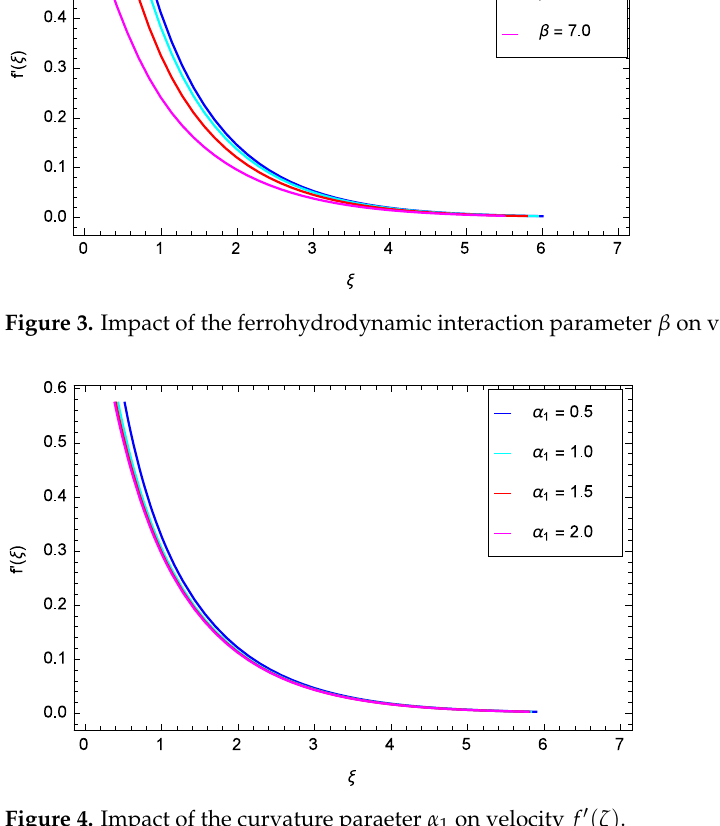
Figure 4. Impact of the curvature paraeter α 1 on velocity f (cid:48) ( ζ ) .